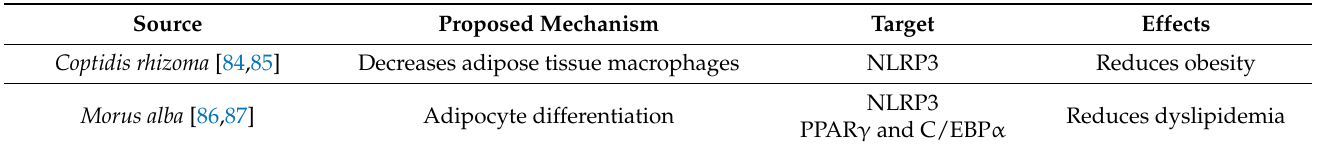
Table 6. Herbal extracts active on NLRP3 inflammasome.